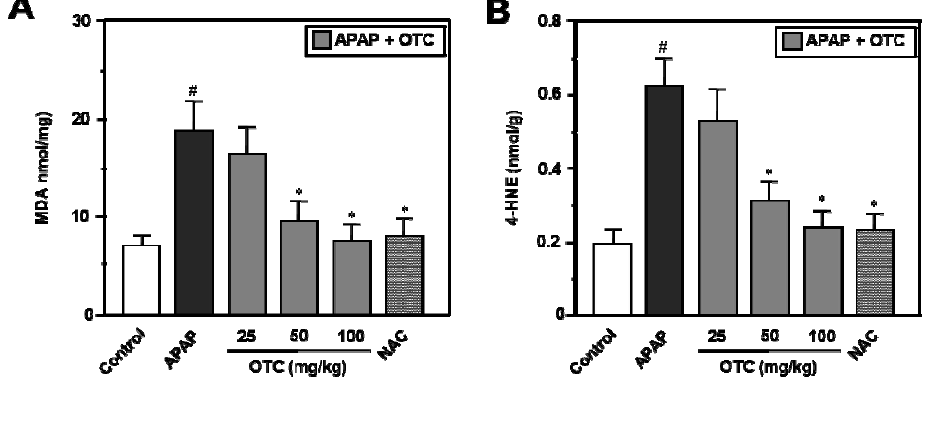
Figure 3. OTC administration reduces MDA and 4-HNE levels in APAP-induced hepatotoxicity. Mice were orally treated with saline or OTC or NAC 2 h before injection of 300 mg/kg APAP. Twelve h after APAP injection, liver tissues were collected for measurement of MDA and 4-HNE. MDA ( A ) and 4-HNE ( B ) levels were decreased in APAP-overdose mice in a dose dependent manner by OTC. Data represent mean ± SE of n = 6 animals per group. # p < 0.005 vs . control group, * p < 0.01 vs . APAP alone